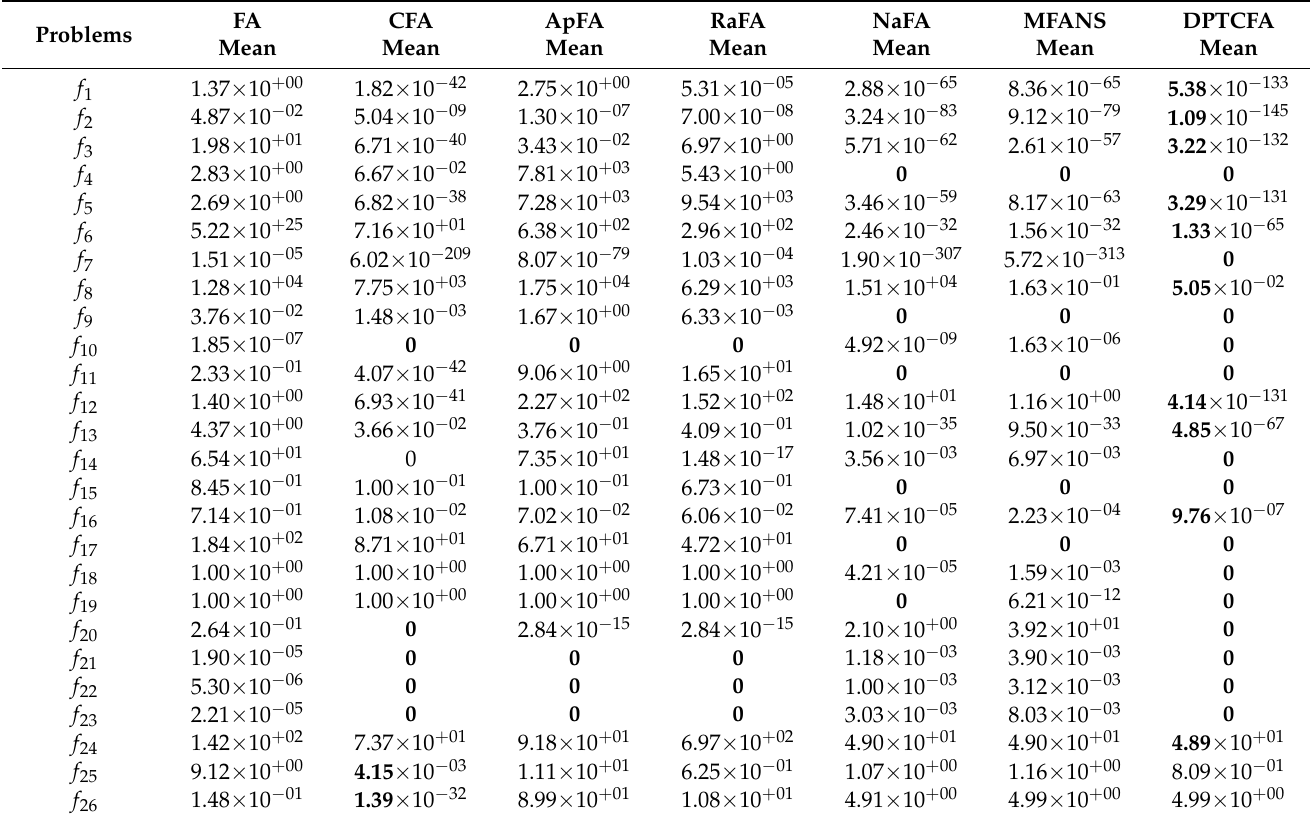
Table 6. Comparison results obtained by DPTCFA and other FA variants ( D =